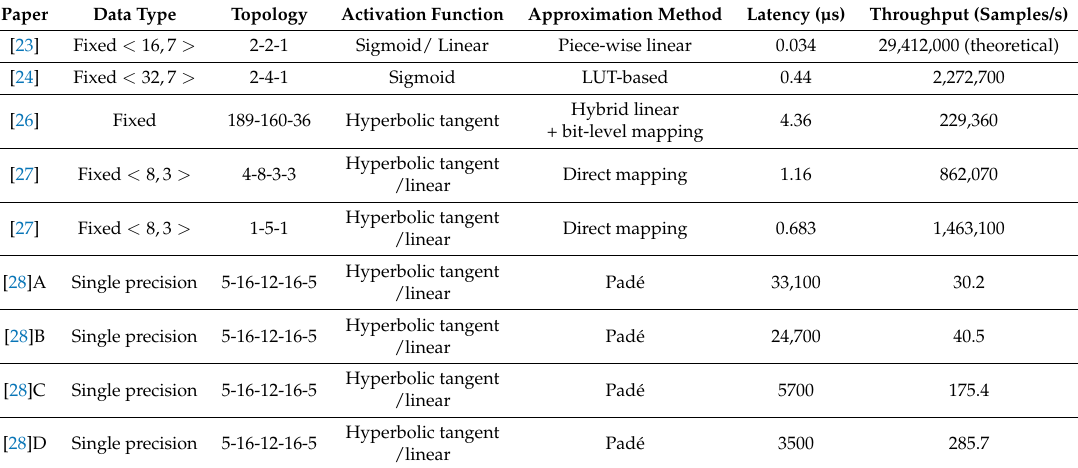
Table 1. Summary of the NN topologies and the performance metrics from the related articles.